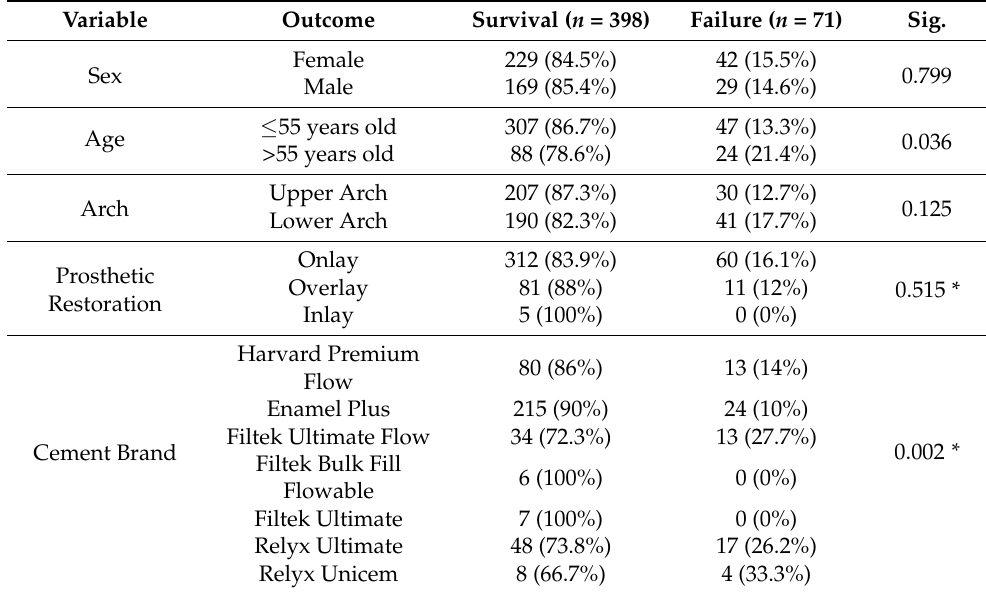
Figure 3. Outcome-related findings: ( a ) failed onlay on 47 because of secondary caries; ( b ) failed overlay after sandblasting in lab; ( c ) fitted onlay after two years; ( d ) fractured onlay; Palacky University Hospital, 2014–2018 ( n = 469). Table 2. Characteristics of survived vs. failed composite restorations, Palacky University Hospital, 2014–2018 ( n =